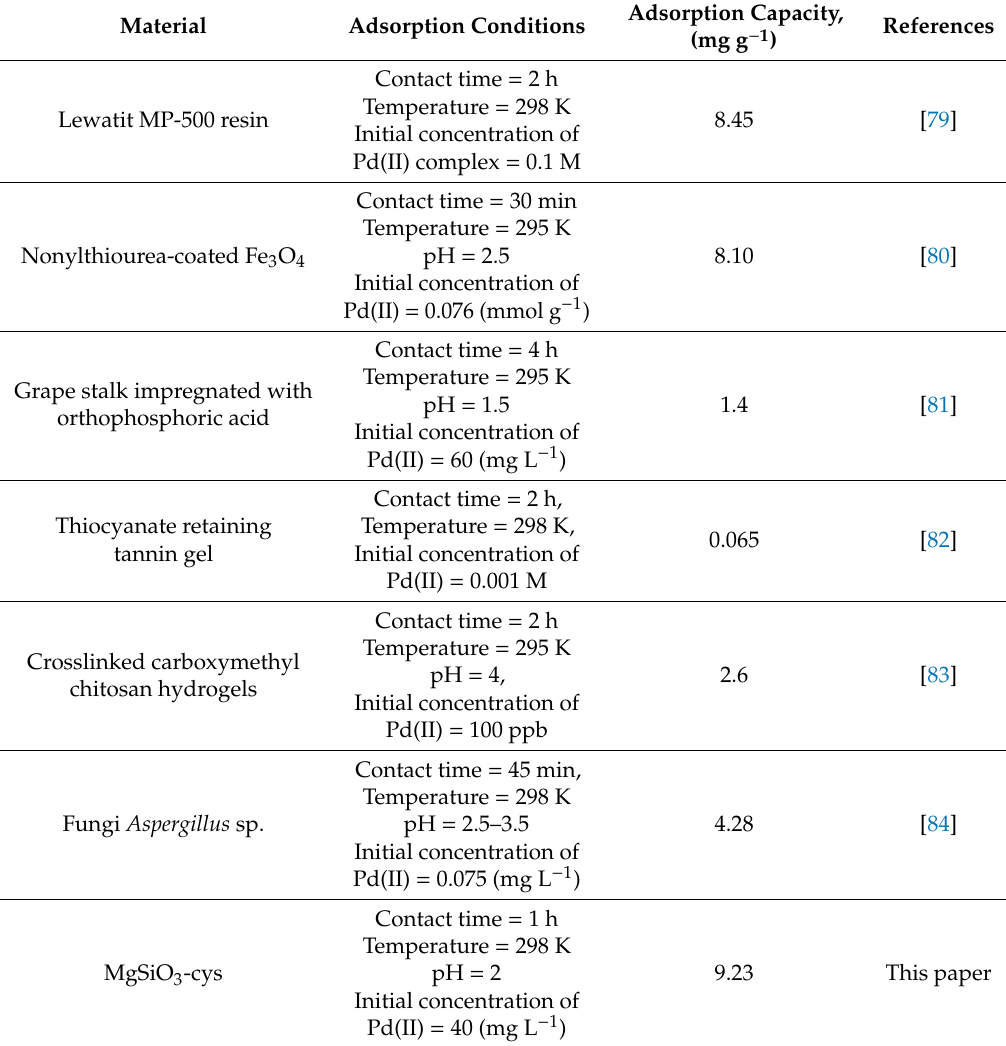
Table 3. The equilibrium adsorption capacity of di ff erent sorbents reported in literature compared to the proposed MgSiO 3 -cys